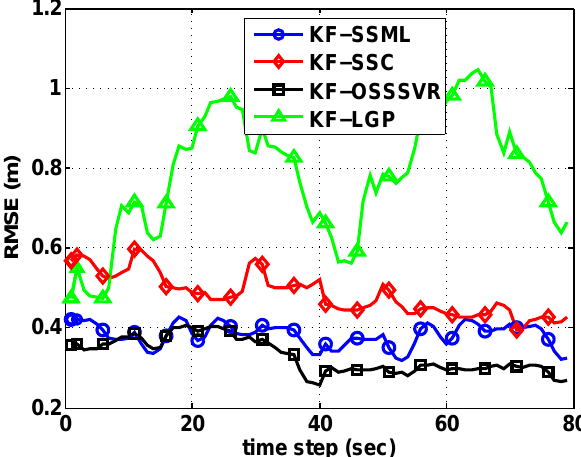
Figure 6. Comparison of Kalman filter-based localization of SSML, GP and our